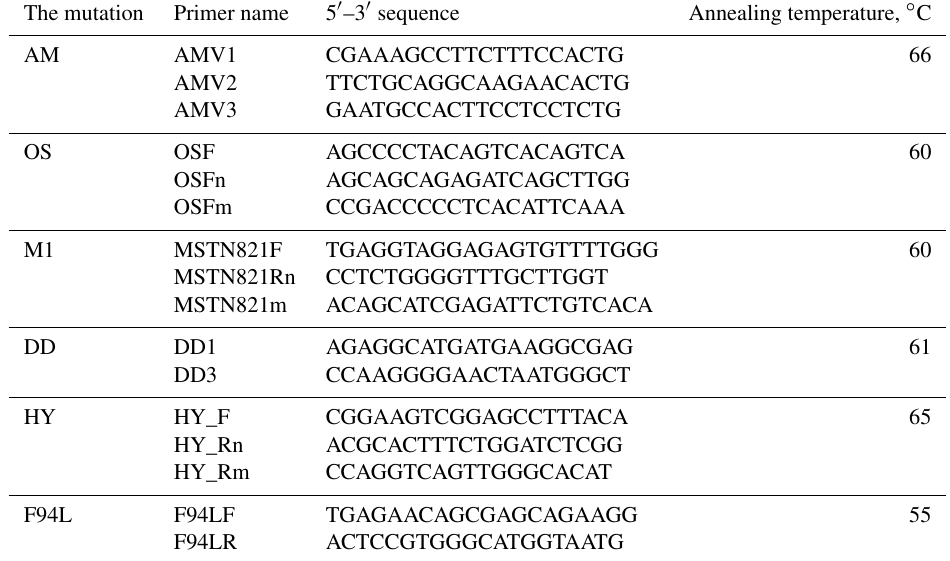
Table 2. The sequences of the oligonucleotide primers for the DNA analysis of AM, OS, DD, M1, MSUD, HY and F94L mutations. The mutation